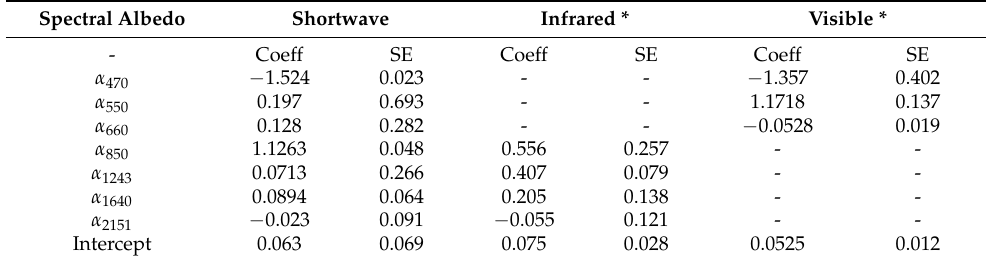
Table 2. Broadband albedo conversion coefficients and standard error (SE) (* p < 0.05).